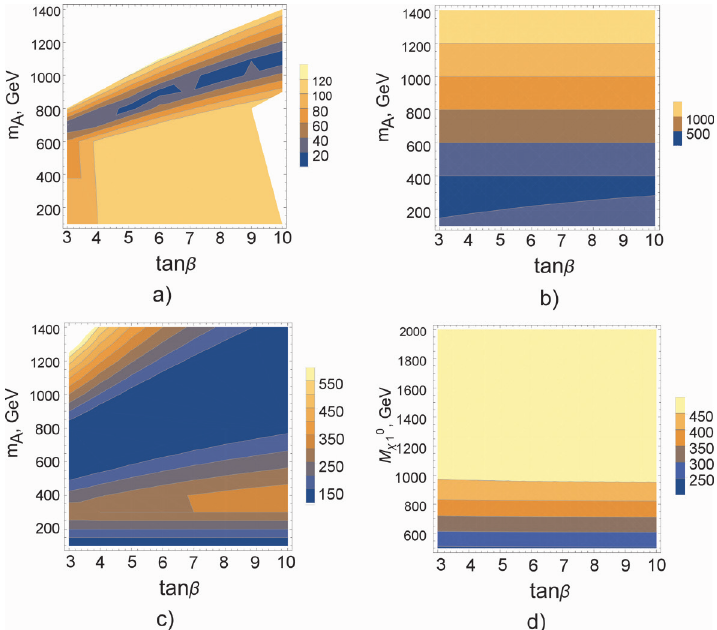
, b) for m h , c) for m h , d) for m . The white area ˜ χ 0 1 1 2 3